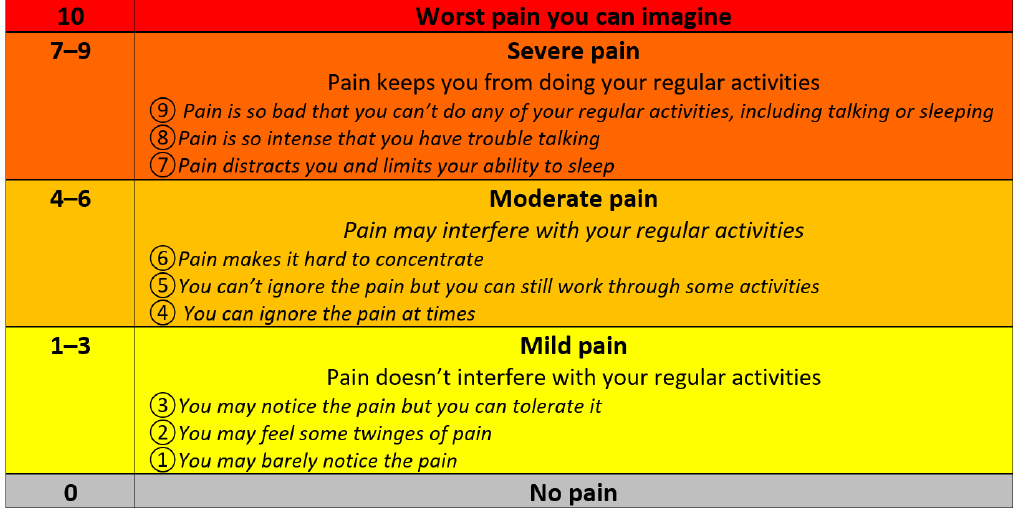
Figure 2. The Universal Pain Assessment Tool — items used for pain.